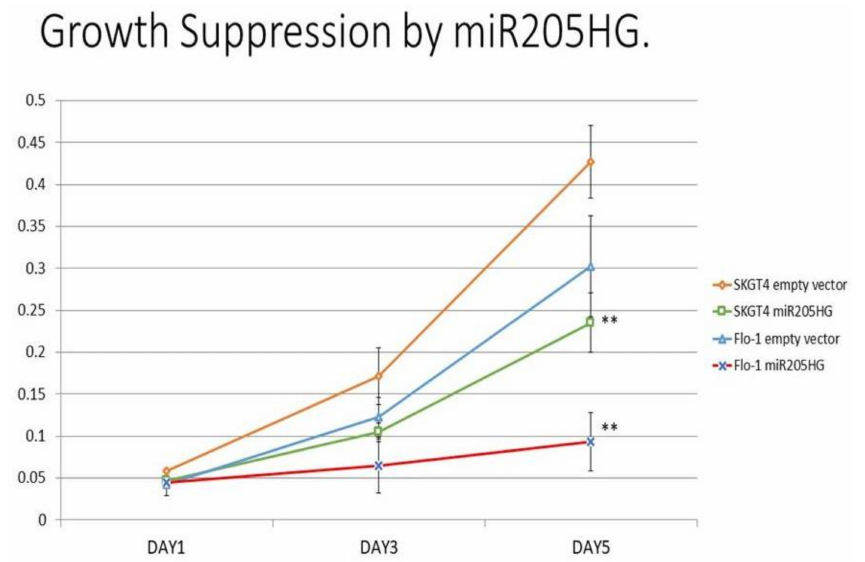
Figure 8. Effect of miR205HG -stable transfection on proliferation of EAC cells. miR205HG stably transfected clones were studied in water-soluble tetrazolium salt (WST-1) assays to detect the effect of exogenous miR205HG overexpression on proliferation of SKGT4 and FLO-1 EAC cell lines. Compared to vector-only transfected negative control, forced overexpression of miR205HG decreased cell prolif- eration on Day 5 by 45% and 69% in SKGT4 and FLO-1 cells, respectively (** p -values all <